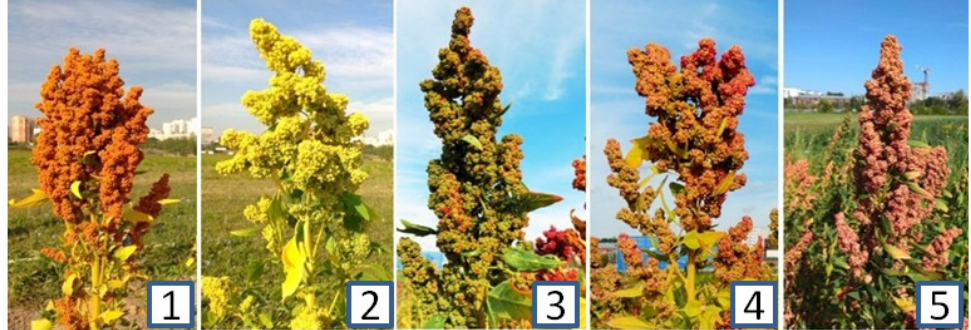
Figure 1. Quinoa inflorescence (panicles) at the grain maturation period: ( 1 ). Titicaca; ( 2 ). Regalona; ( 3 ). Brightest Brilliant; ( 4 ). Red Faro; and ( 5 ). Cherry Vanilla (Field station of RSAU–MTAA, 2020).